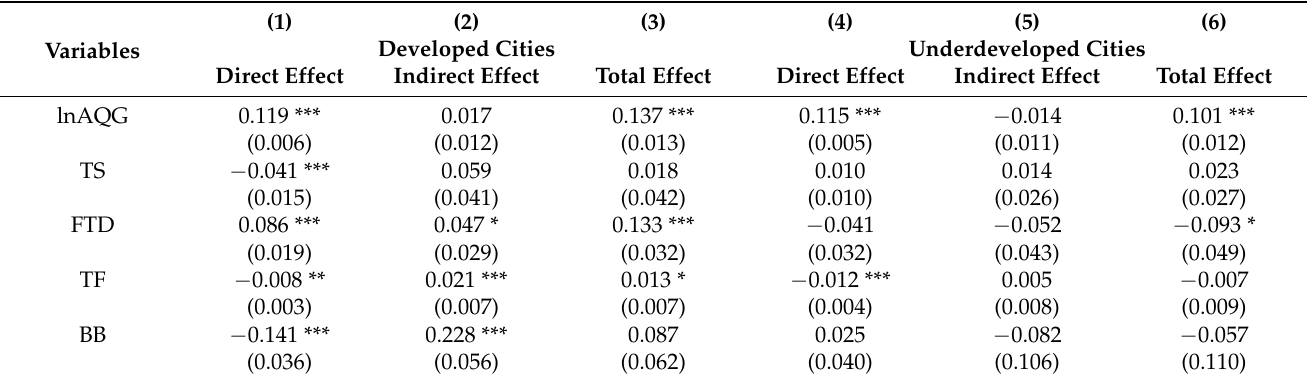
Table 10. Decomposition effect of different urban development